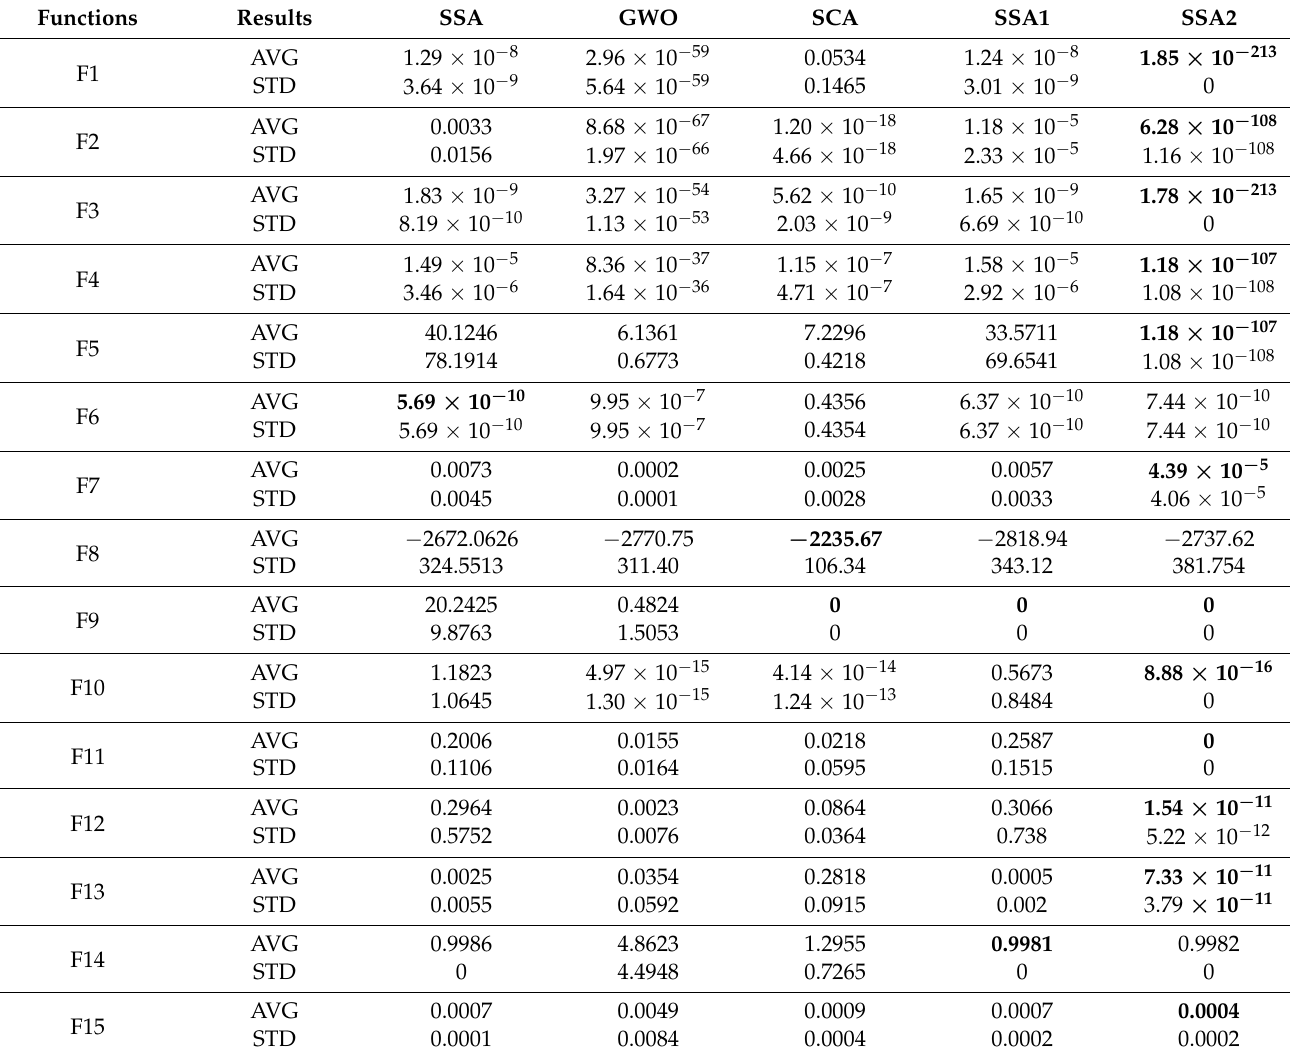
Table 4. Benchmark function test